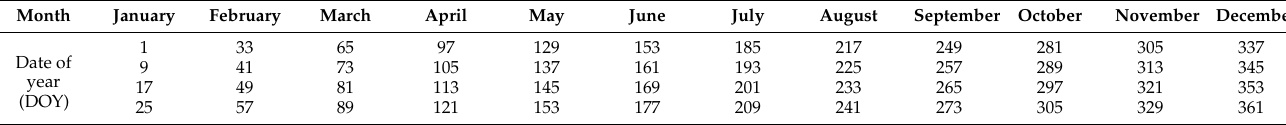
Table 2. The corresponding relationships between DOY and